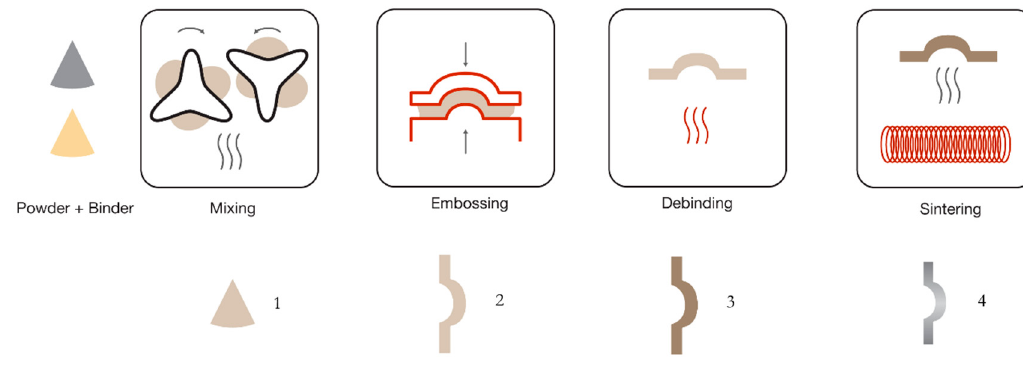
Figure 1. Powder hot embossing technology flowchart.